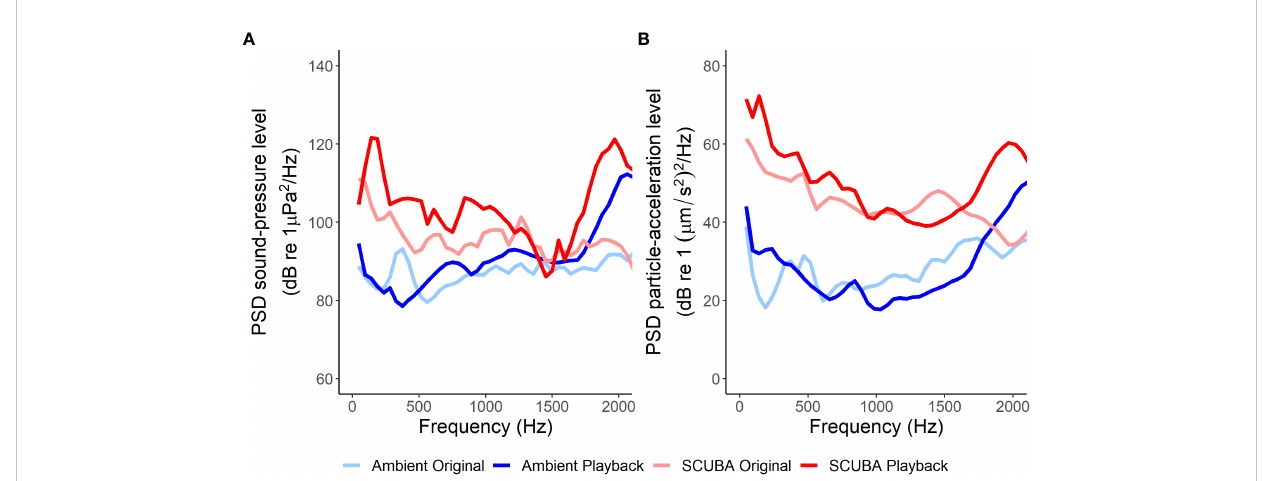
FIGURE 2 Mean power spectral densities (PSD) of the original ambient-sound recordings, ambient-sound playback tracks, original SCUBA-noise recordings and SCUBA-noise playback tracks in terms of sound pressure (A) and particle acceleration (B) , giving an average sound pro fi le for each treatment (fft length = 1024, Hamming evaluation window, 50% window overlap, 0 – 2 kHz).